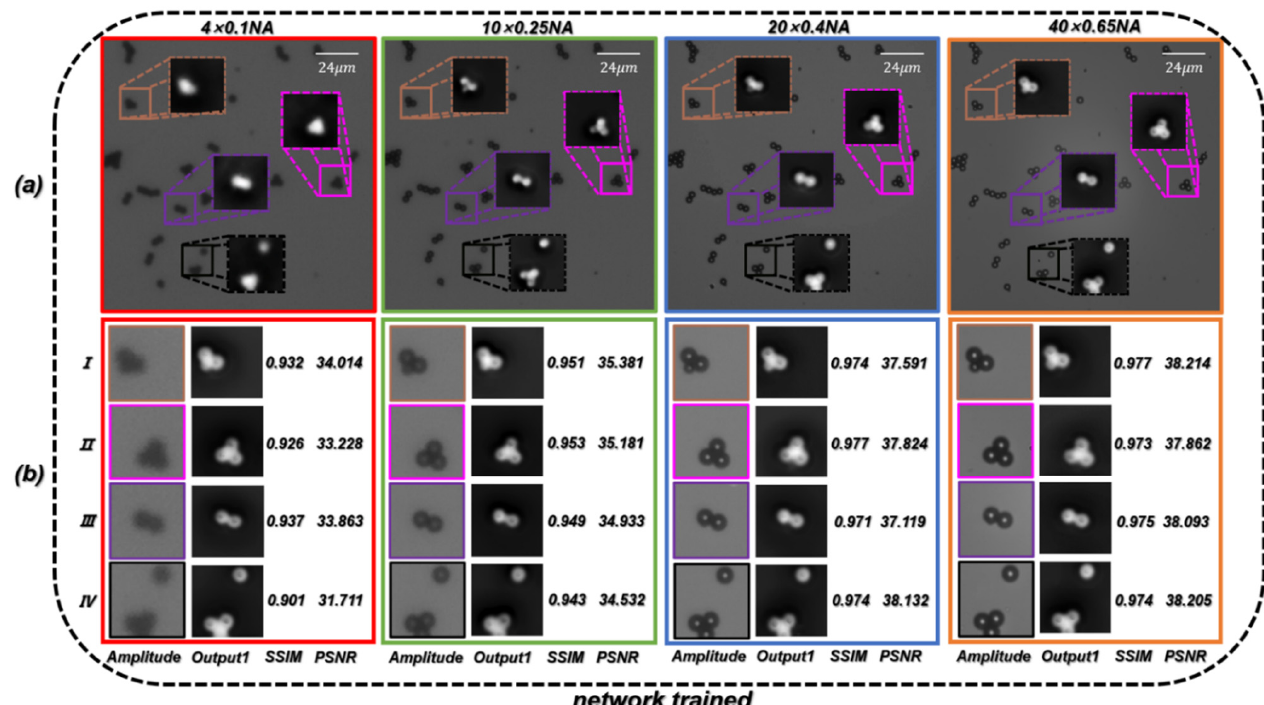
Figure 6. Test results of PSMs by the ContransGAN-All. ( a ) Microscopic images of the same FOV under a different NA objective and the quantitative phase images reconstructed by TIE. ( b ) Results for the corresponding region. Ground truth labels are the quantitative phase images under the 40 × /0.65 NA objective in ( a ); SSIM values and PSNR reflect the quantitative relationship between ground truth labels and Output1.